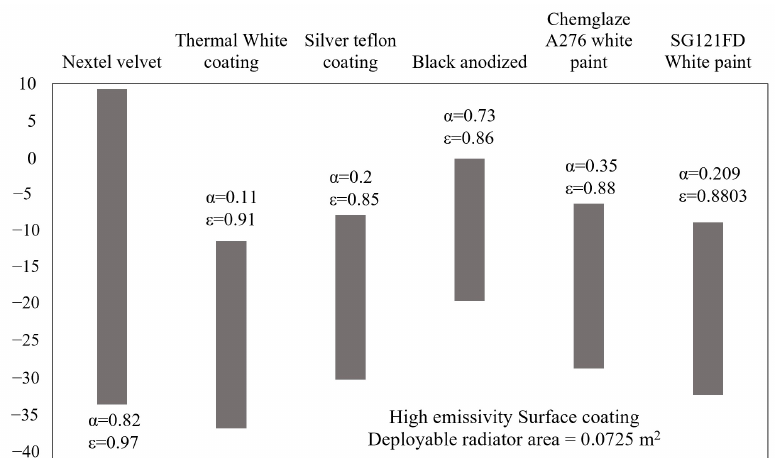
Figure 29. DR Surface coating